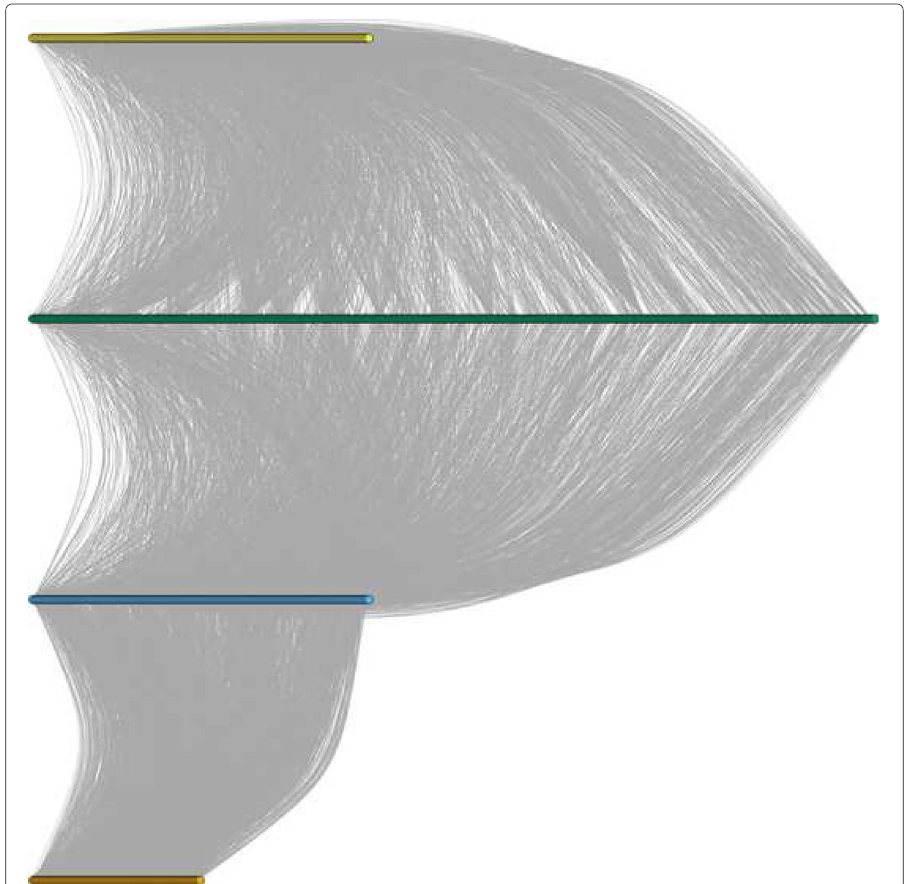
Fig. 4 A visual representation of the tiered structure of artificial SCN synthesized using ABNG replicating basic SCN properties of power law degree distributions and disassortative mixing. The network consists of 1000 nodes (100, 200, 500, 200 nodes in tiers 0, 1 ,2, 3 respectively) and 7000